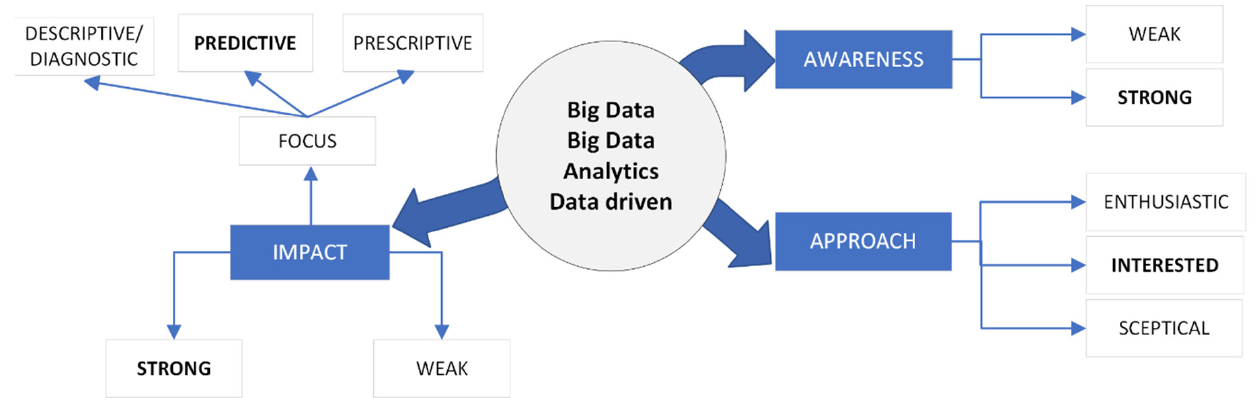
Figure 1. Big Data, Big Data Analytics and Data-driven approach–Awareness and business impact.